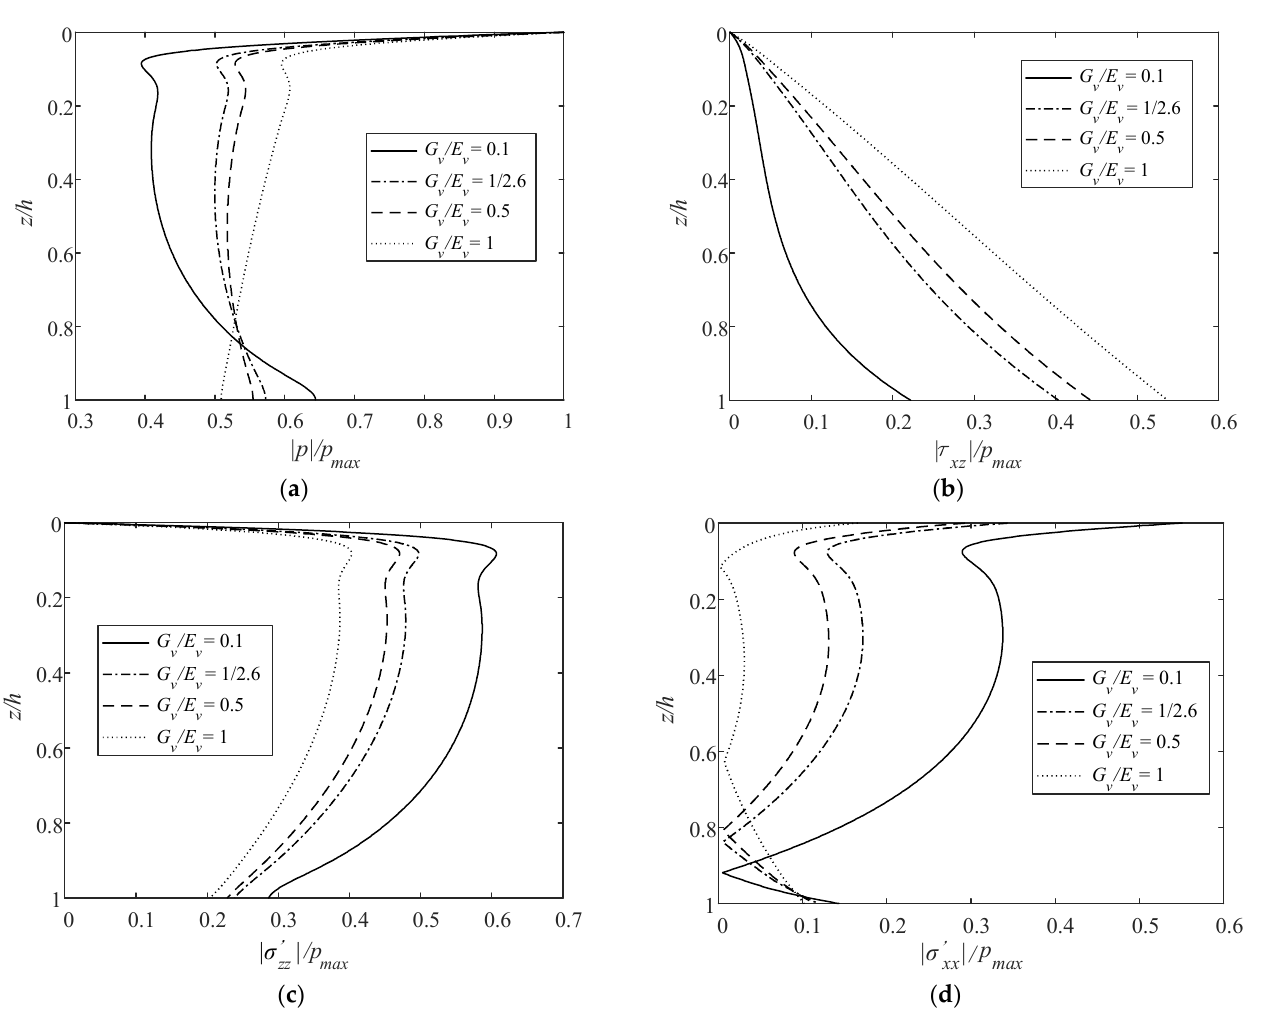
Figure 12. Maximum liquefaction depth z max varying with E v /E h for various ( a ) degrees of saturation, ( b ) wave periods, ( c ) soil porosities, ( d ) current velocities. Figure 13 shows the vertical distributions of normalized | p| , | τ xz |, | σ (cid:48) zz | , and | σ (cid:48) xx | for various ratios of vertical shear modulus to vertical Young’s modulus G v /E v , where G v /E v = 1/2.6 and corresponds to the isotropic case. A fixed value of E v = 2.6 × 10 7 Pa is chosen. Similar to E v / E h , G v /E v changes all vertical distributions of | p| , | τ xz |, | σ (cid:48) zz | , and | σ (cid:48) xx | . Especially, z max at | σ (cid:48) xx | = 0 is more significantly affected by G v /E v than by K v / K h and E v / E h , referring to Figure 9d, Figure 11d, and Figure 13d.